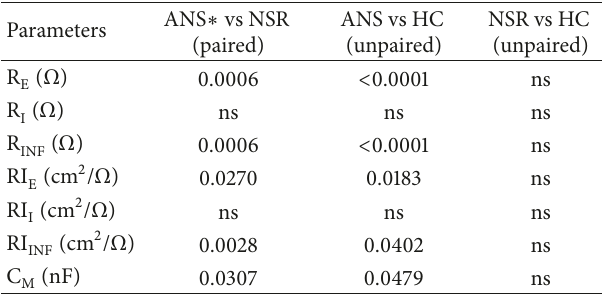
Table 5: Statistical comparison of results from Table